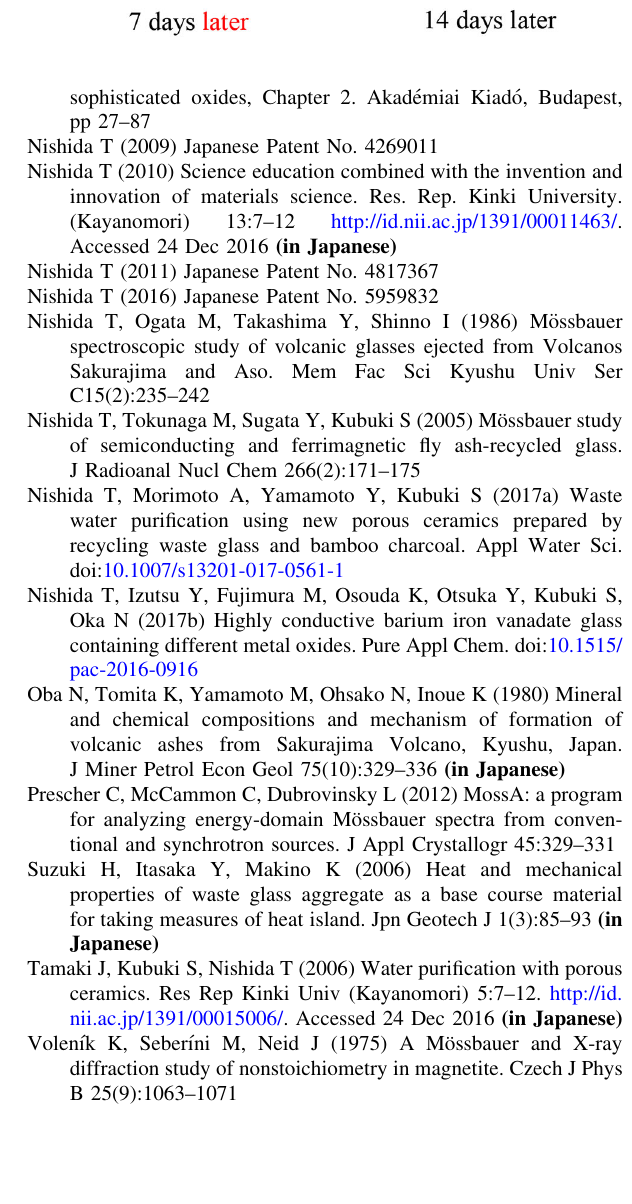
Fig. 6 Photos of the artificial 100 cm) before and after the purification test with